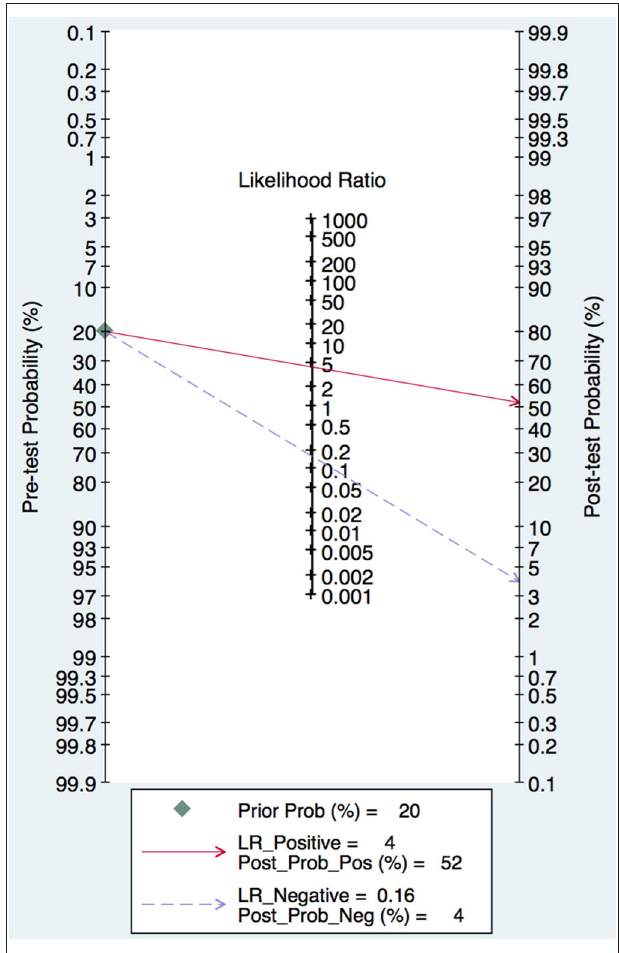
FIGURE 5 | Fagan’s Nomogram for assessment of post-test